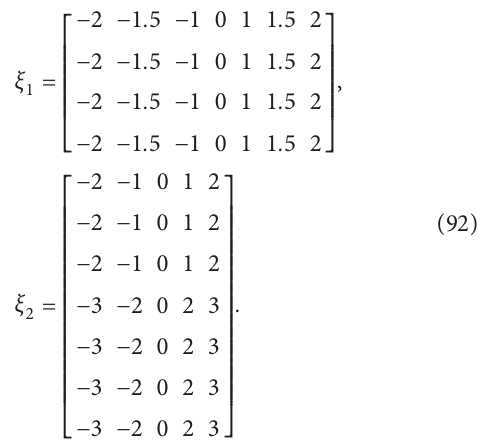
Figure 10: Adaptive parameters 􏽢 θ